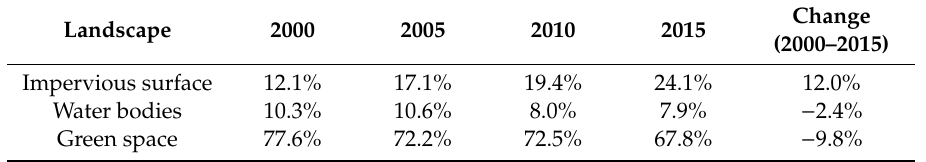
Table 3. Changes in area proportions of major landscape in the HMA during 2000–2015.